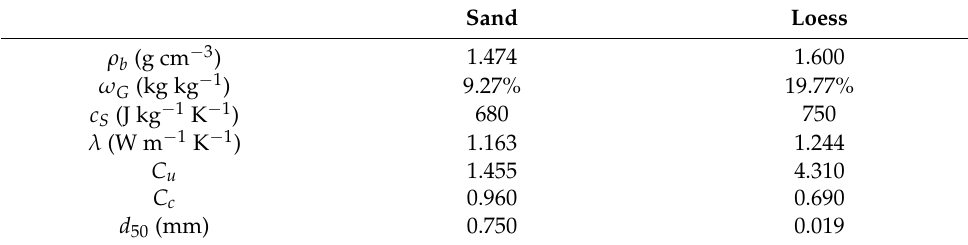
Figure 3. Schematic of the experimental setup: ( a ) the vertical perspective of the model box, ( b ) the front perspective of the model box, ( c ) the photograph of the cable spacing in loess, ( d ) the photograph of the cable structure, and ( e ) the photograph of the cable spacing in sand. Table 1. Characteristics of the soil used.